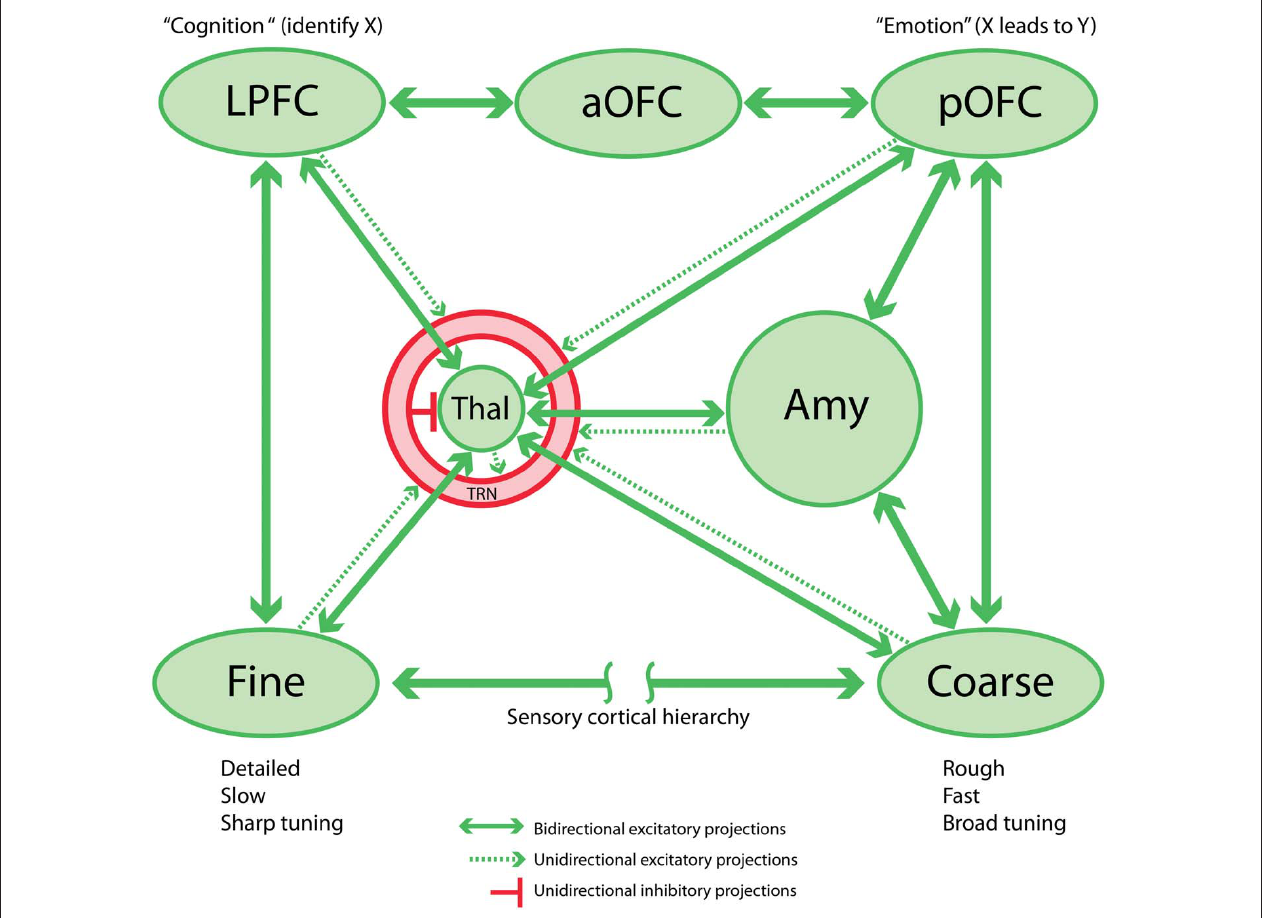
FIGURE 1 | Schematic circuit linking sensory cortex, prefrontal cortex, thalamus, and amygdala. This network is the proposed basis for the sensory aspect of the cognition-emotion continuum or matrix that facilitates flexible, adaptive behaviors. Note that the TRN is shown as a shell around the